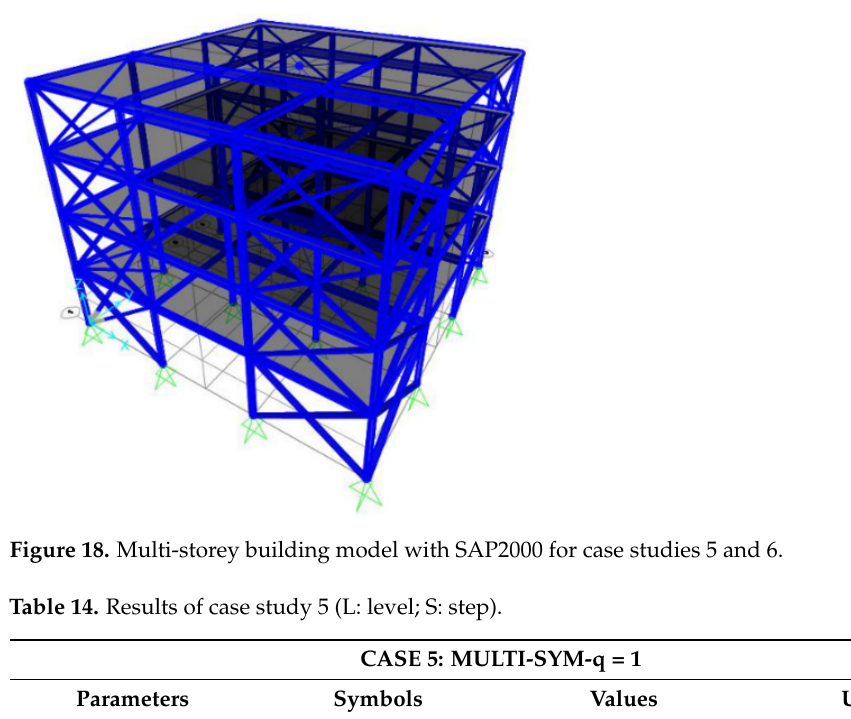
Figure 17. Plan of the multi-storey building with the symmetrical X-CBF configuration (case studies 5 and 6).